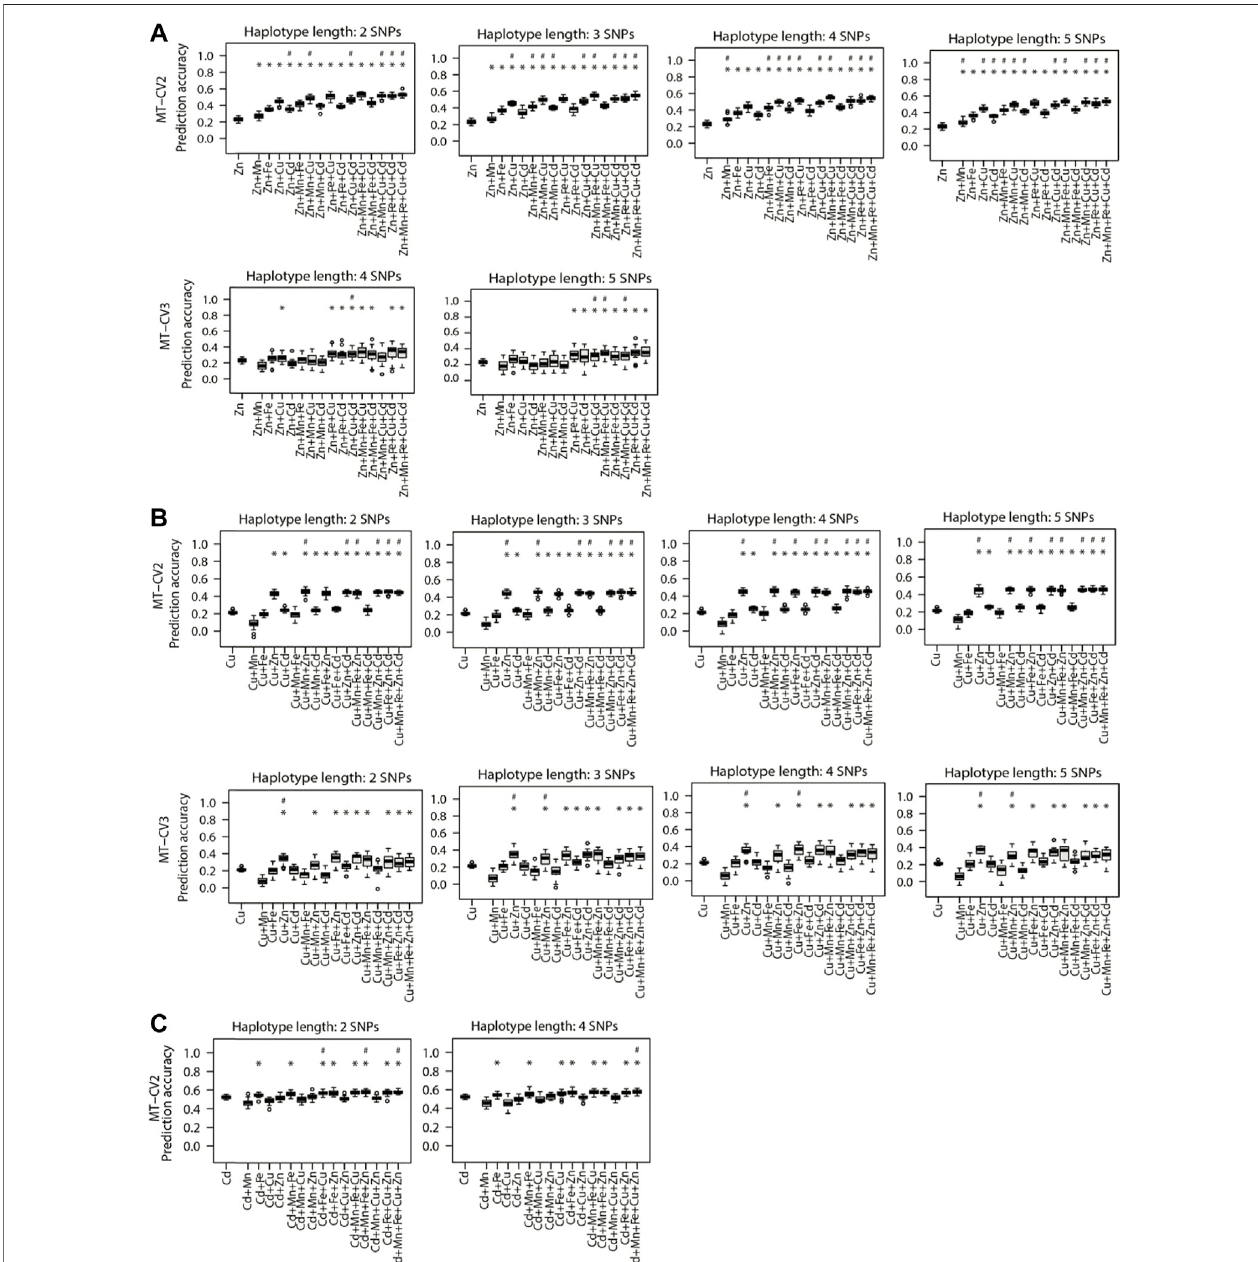
FIGURE5 | Genomic prediction accuracies ofthe genotype-basedsingle trait (ST) model (ST-GBLUP) and haplotype-based multi-trait(MT) model (MT-UN) under different cross-validation (CV) schemes (ST-CV1, MT-CV2, and MT-CV3). The target traits are (A) Zn, (B) Cu, and (C) Cd. The number of SNPs contained in haplotype blocks ranged from three to fi ve. The fi rst box-whisker in each portrayal indicates the accuracies of the ST-GBLUP model in the ST-CV1 scheme. Other box-whiskers refer to the accuracies achieved by MT models with different trait combinations. Asterisks above box-whiskers indicate that the prediction accuracies of the haplotype-based MT-UN model for the speci fi c trait combination were statistically signi fi cantly ( p < 0.05, t -test) higher than those of the ST-GBLUP approach. Pounds above box-whiskers indicate that the prediction accuracies of the haplotype-based MT-UN model were statistically signi fi cantly ( p < 0.05, t -test) higher than those of its correspondinggenotype-basedcounterparts.Onlythescenarioswherethehaplotype-basedMT-UNmodelwerestatisticallysigni fi cantlyoutperformed( p < 0.05, t -test) the genotype-based MT-UN model are presented.